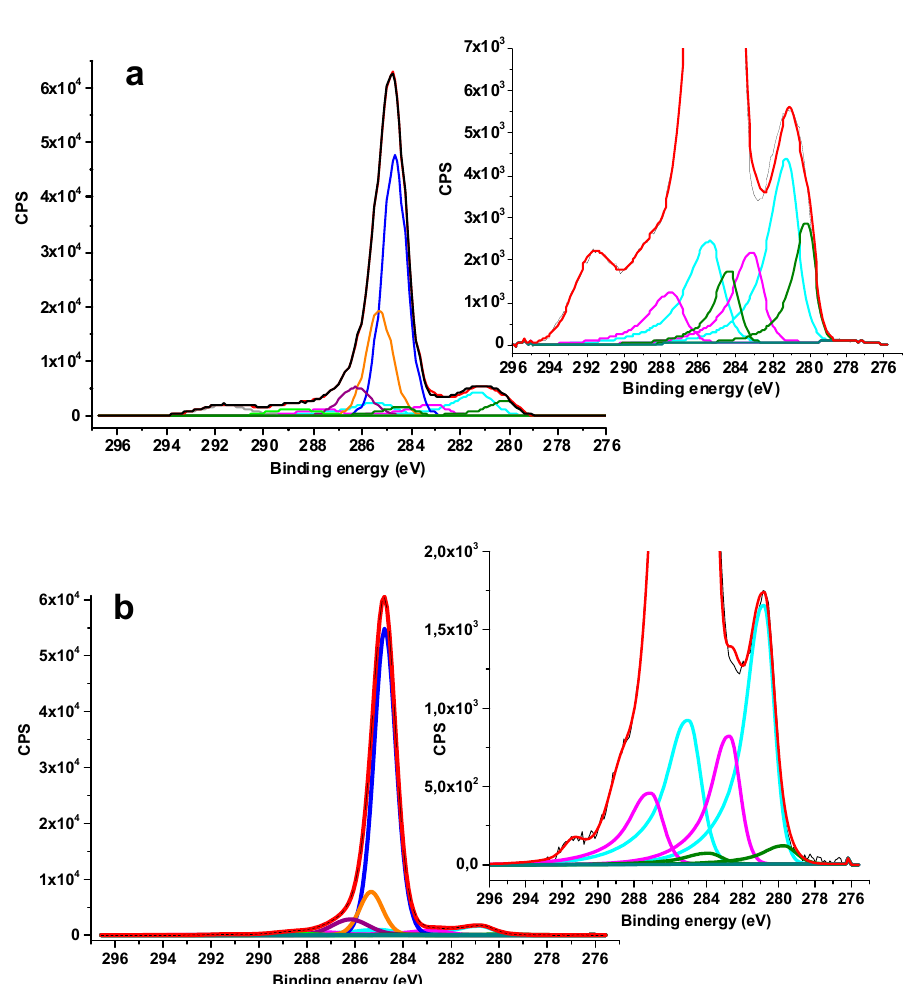
Figure 5. HR XPS C 1s and Ru 3d of Ru-PPP ( a ) and Ru-PPP-S ( b ). Black line is the experimental data, the blue line is for sp2 carbon, orange line is for C − N and adventitious sp3 carbon, the purple line is for C − O, the light green line is for COOH, the grey line is for π−π interactions in sp2, the olive lines are for Ru (0), the cyan lines are for RuO 2 , the magenta lines are for RuO 2 satellite, the dark cyan line is for background and the red color is for the fitting curve. The scaled spectra depict the deconvolution of Ru spectrum without the lines corresponding to C 1s spectrum for more clarified representation. See Table S3 for the deconvolution data.